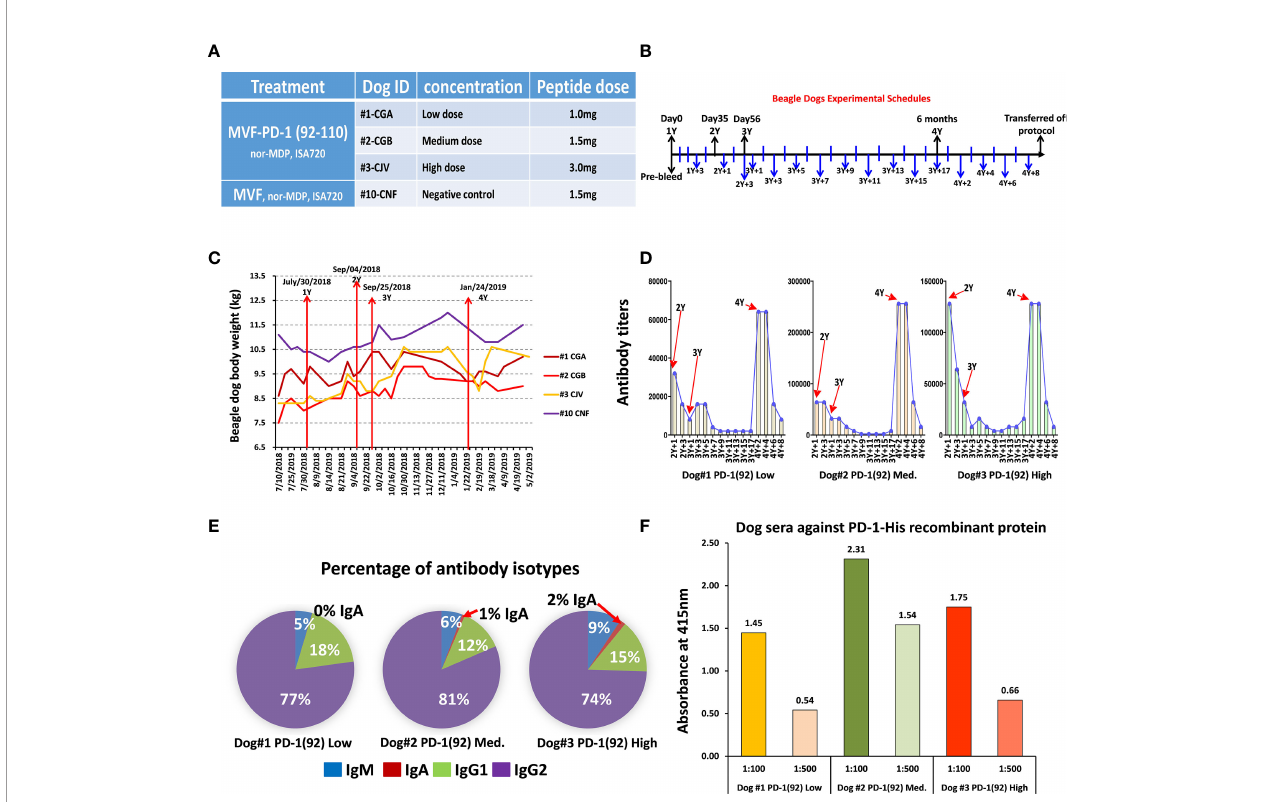
FIGURE 3 | Immunogenicity and safety in Beagle dogs. (A) There were 4 beagle dogs involved in this study. Dog #1, #2, and #3 were treated with single MVF-PD-1(92- 110) nor-MDP and ISA 720 with different doses. Dog #10 was a negative control; (B) Dogs were immunized 4 times, which point to 1Y, 2Y, 3Y, and 4Y at day 0, day 35, day 56, and 6 months after primary immunization, respectively. Blood was collected every two weeks except the fi rst collection was 3 weeks after the primary immunization and 1 week after 2Y and 3Y immunization. The sera were used to monitor the antibody titers. All the beagle dogs were transferred out of protocol after this preclinical study. (C) The plot of dogs ’ body weight during the experimental period. (D) Immunogenicity of peptide-based vaccines in beagle dogs. ELISA were used to detect antibody titers in sera. (E) Isotypes IgM, IgA, IgG1, and IgG2 in canine were detected after being immunized with MVF-PD-1(92) peptide vaccine. (F) Dogs ’ sera antibody activity with human recombinant protein PD-1